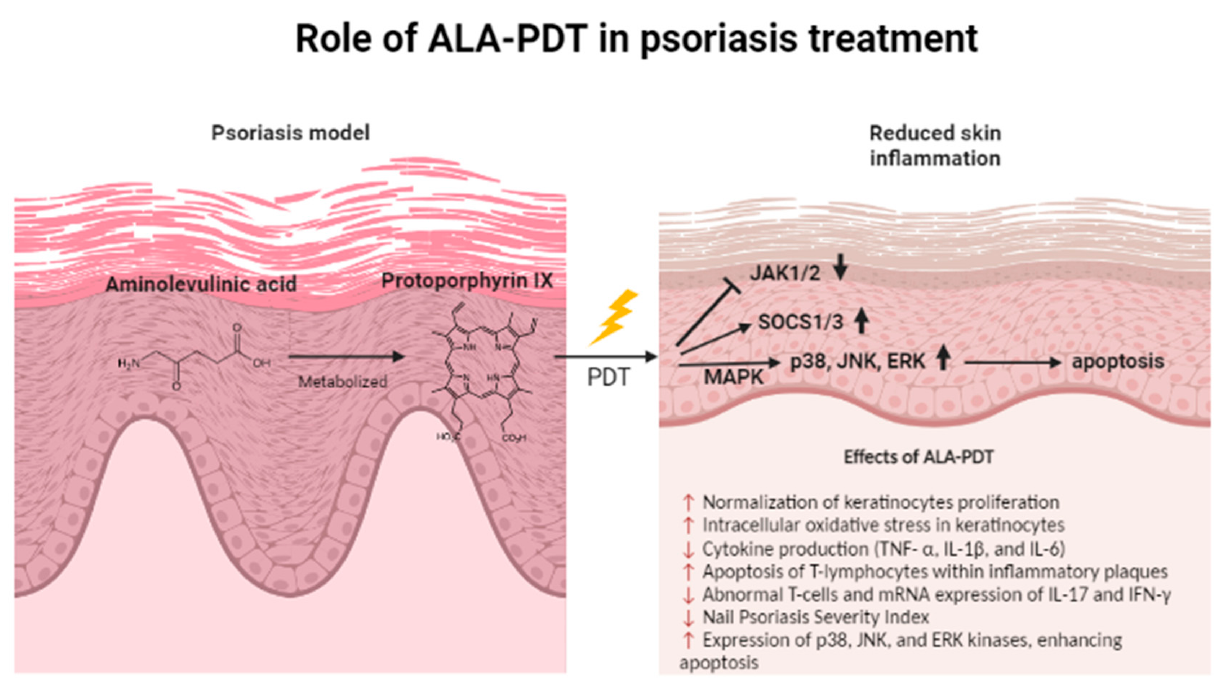
Figure 1. The role of ALA-PDT in psoriasis treatment. Aminolevulinic acid (ALA) is metabolized by cells into protoporphyrin IX (PpIX), which may be subsequently activated by visible light. The effects of ALA-PDT on a psoriasis model and the affected genes have been summarized.